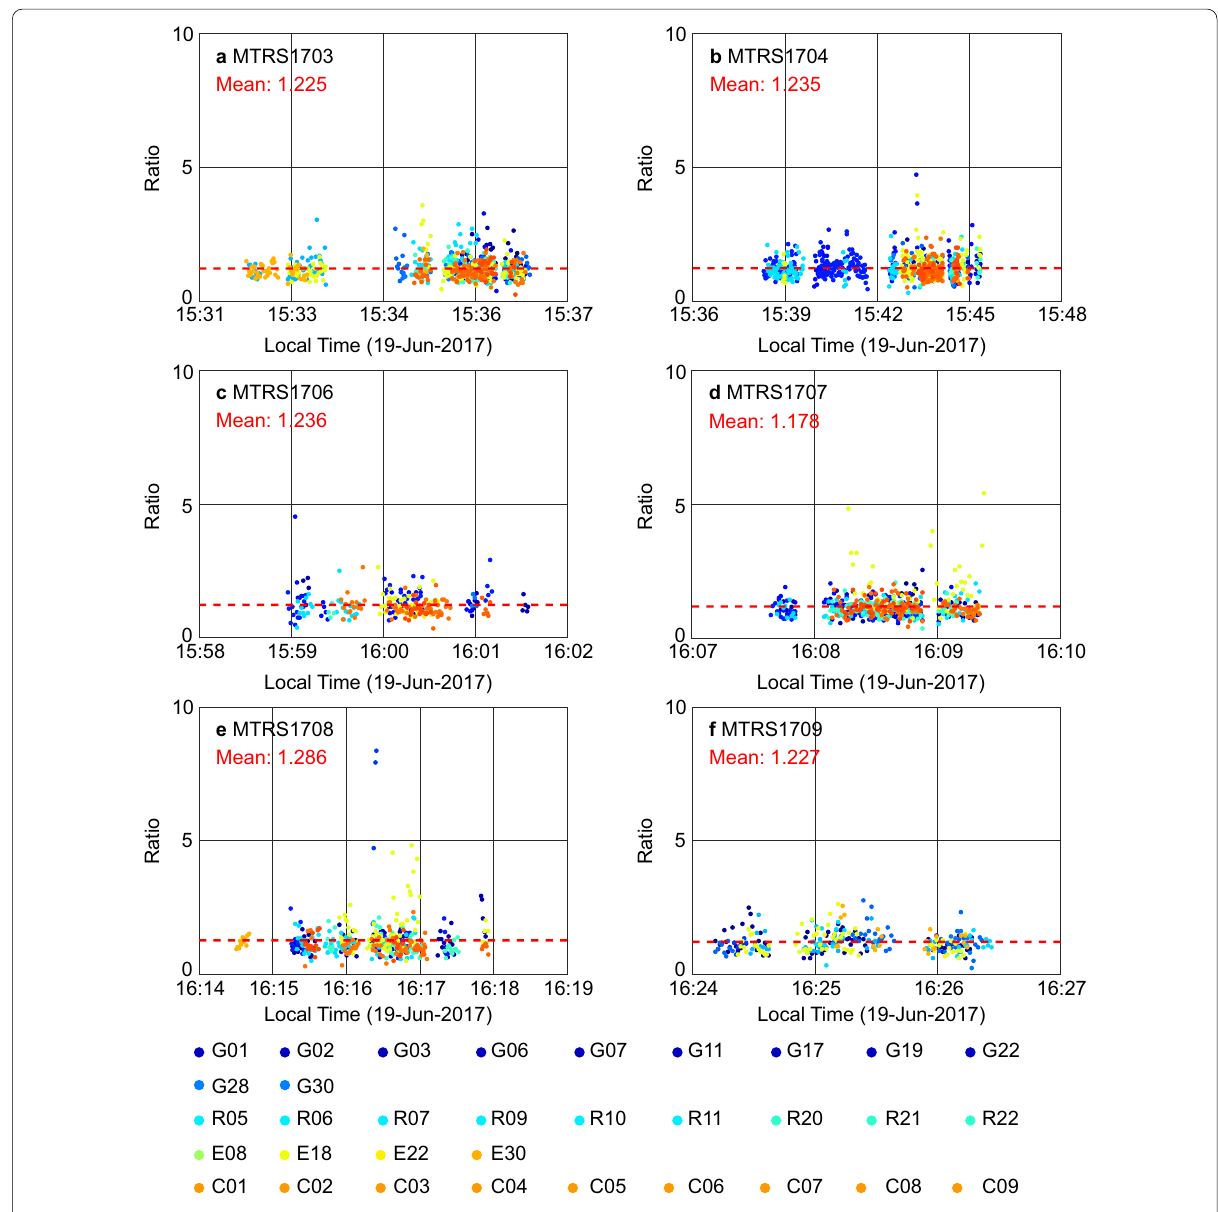
Fig. 14 Ratio between the RMS derived from the moving station and static station for each satellite. The results of the six travels are presented in ( a – f ). The ratio value is calculated at the interval of 1 s, which means N is equal to 20. The red dashed line denotes the average value of the ratios of all the